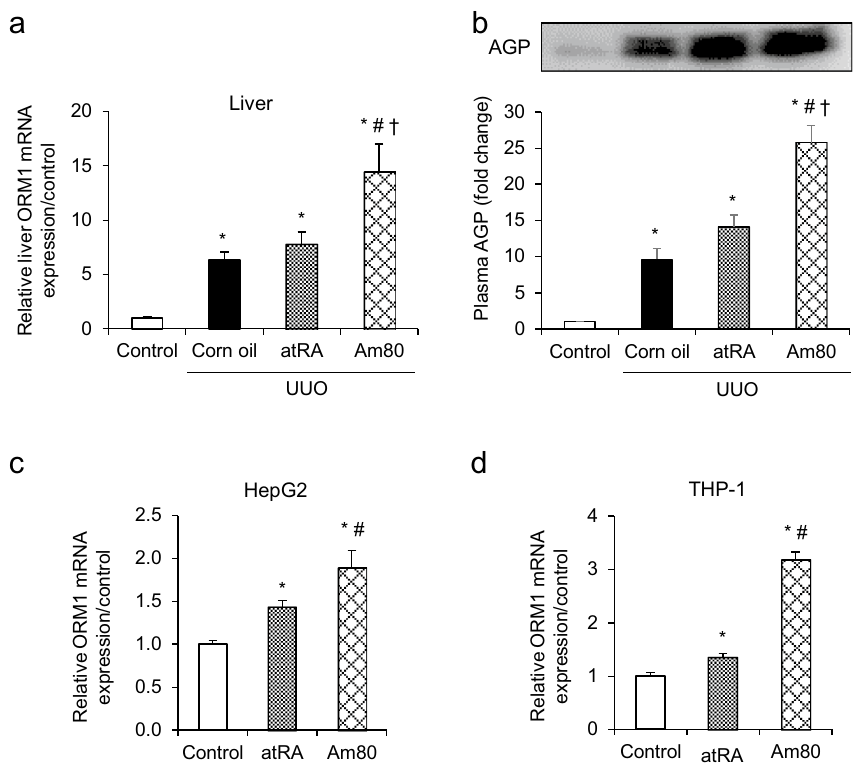
Figure 2. Am80 treatment increases ORM1 expression both in vivo and in vitro . ( a ) Hepatic ORM1 expression in the UUO-treated mice at day 7. ( b ) Plasma AGP protein expression in the UUO-treated mice at day 7. *P < 0.05 compared with the control mice. The full-length gel and bands are included in the Supplementary Fig. 2. # P < 0.05 compared with the corn oil-treated UUO mice. † P < 0.05 compared with the atRA-treated UUO mice. (n = 4 for control group; n = 5 for each UUO group) ( c , d ) mRNA expression of ORM1 in HepG2 and THP-1 cells after incubation with atRA or Am80 (0.1 μM). *P < 0.05 compared with control; # P < 0.05 compared with atRA-treated group. Data are expressed as the mean ± SE (n = 3 for control; n = 4 for atRA or Am80